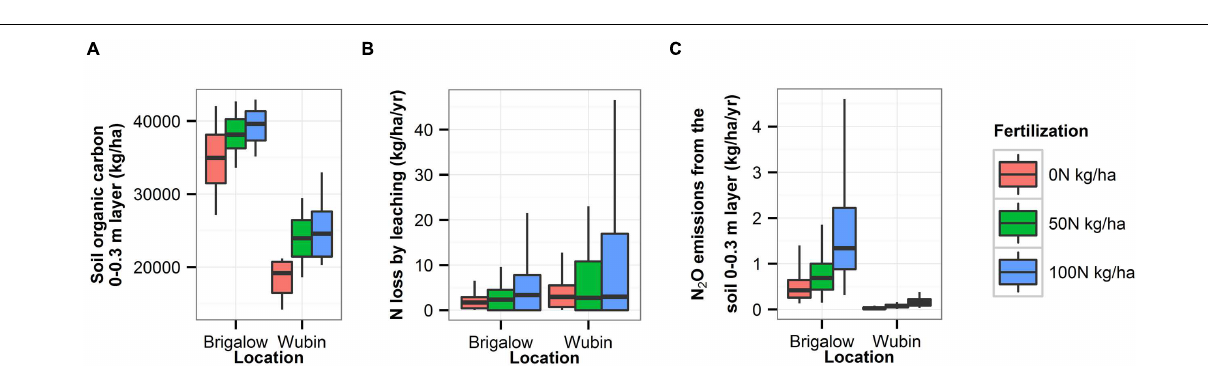
FIGURE 7 | Correlation between average chickpea yield and percentage of change in SOC (0–0.3 m) over 90 years of APSIM simulations.